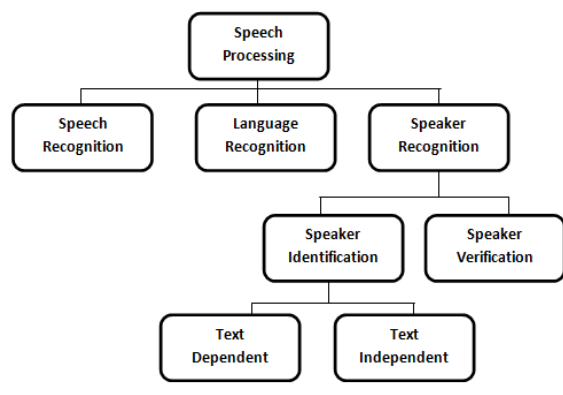
Figure 1. Classification of speaker